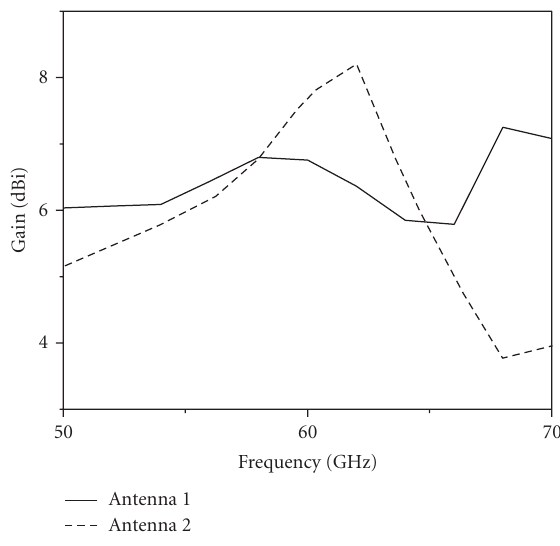
Figure 5: Realized gain for antenna 1 and antenna